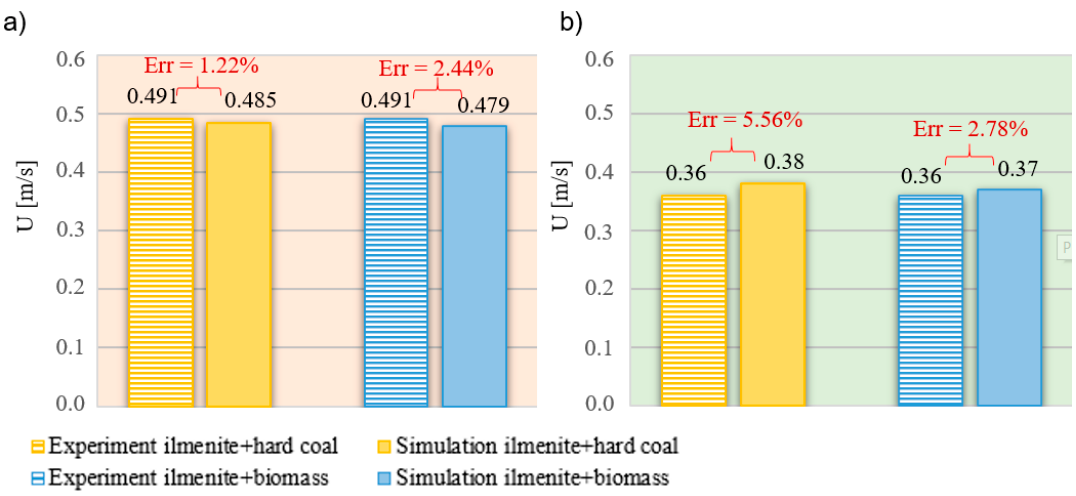
Table 3. Experiment and simulation results concerning emissions in the AR and FR.